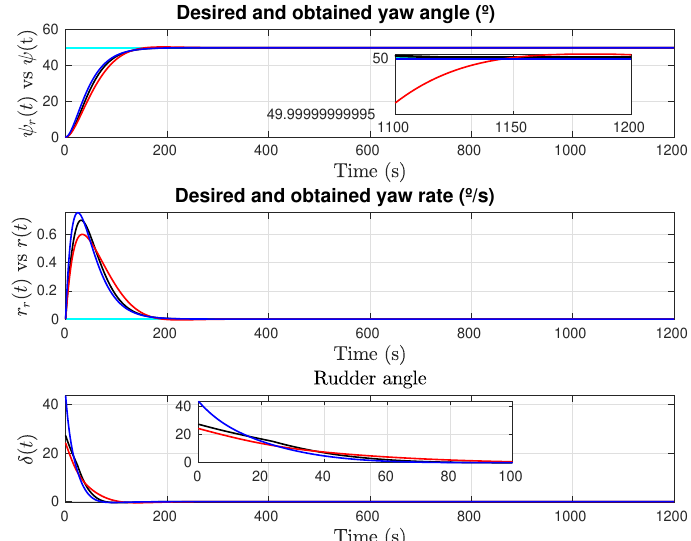
Figure 3. Constant yaw reference test with d ( t ) = 0. States and control. Cyan line: Reference; Red line: Concise backstepping (Zhang et al.); Blue line: Synergetic (Muhammad et al.); Black line: Adaptive sliding mode (González-Prieto et